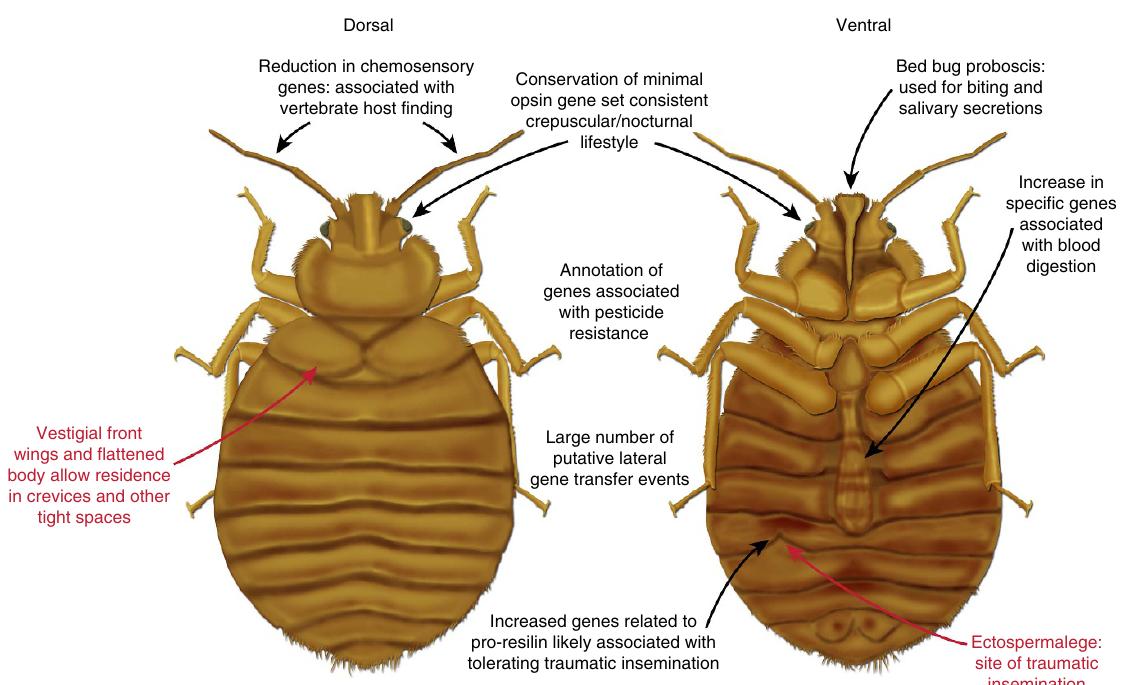
Figure 4 | Synopsis of the contributions from the C . lectularius genome to understanding key biological processes. Red, general characteristics of bed bugs; black, key aspects identified and expanded by genome sequencing and manual